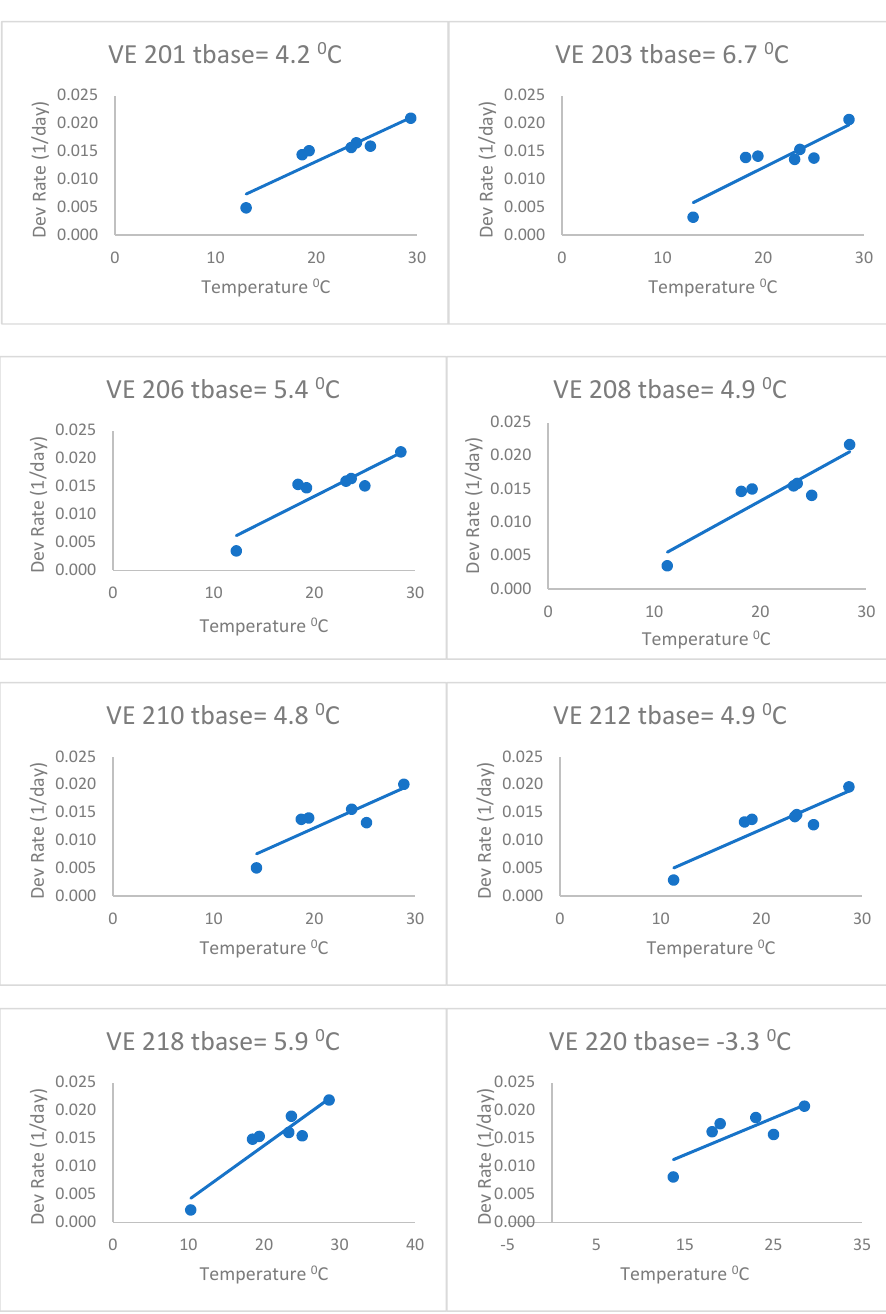
Figure 4. Regression fit to the data for each variety separately. These results are for the equation without the highest temperature data point.